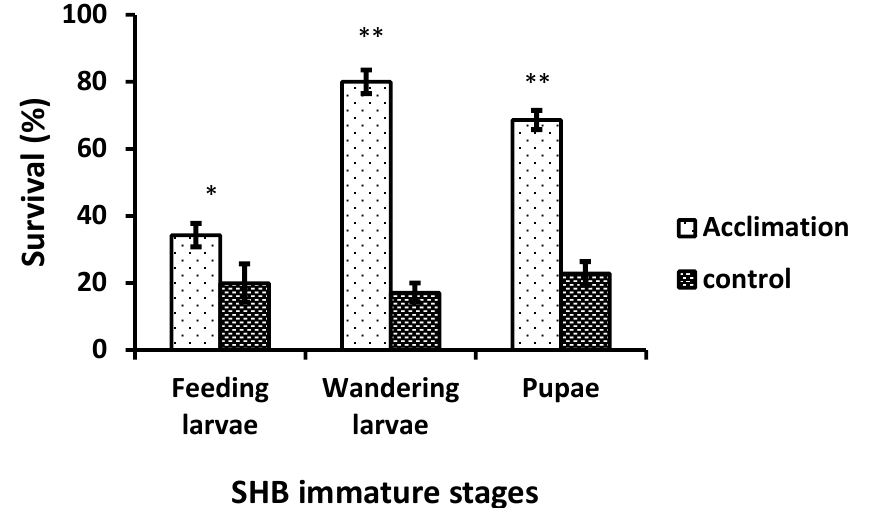
Figure 2. Survival of immature stages of SHB after acclimation. * p < 0.05, and ** p < 0.001.